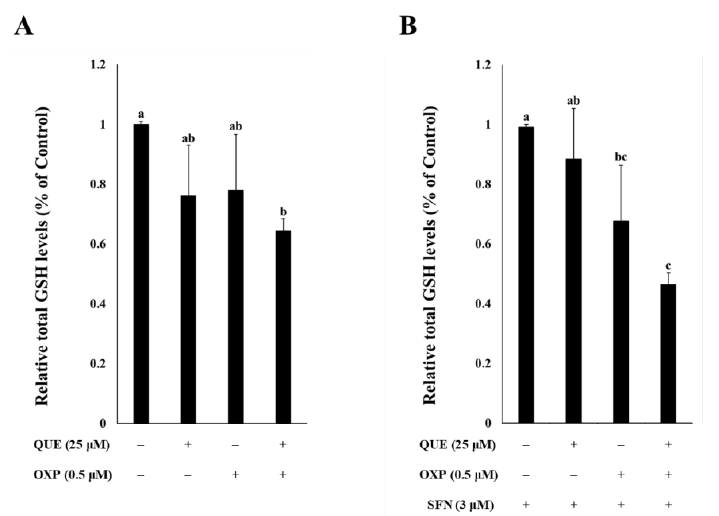
Figure 5. QUE and SFN in combination with OXP decreased intracellular GSH level in HCT116 cells. The cells were treated with different combinations QUE and OXP in the absence ( A ) or presence of SFN ( B ) for 72 h. The total GSH levels were then measured and normalized to the total protein content. Error bars, mean ± SEM ( N = 3). Significant differences among treatments were denoted by different alphabetical letters ( p < 0.05, one-way ANOVA with Duncan’s post hoc HSD test).